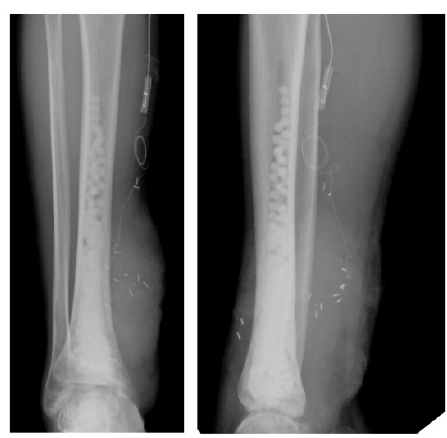
Figure 2. Post-operative radiographs with gentamicin eluting, bioabsorbable composites visible at the site of osteomyelitis